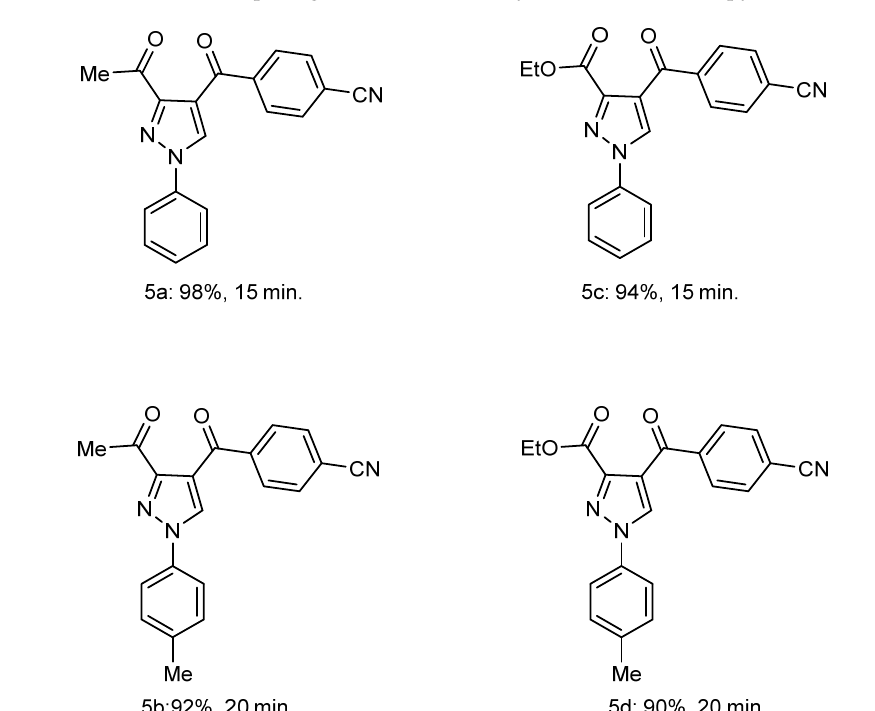
Figure 8. Scope of the synthesis of the pyrazole derivatives.